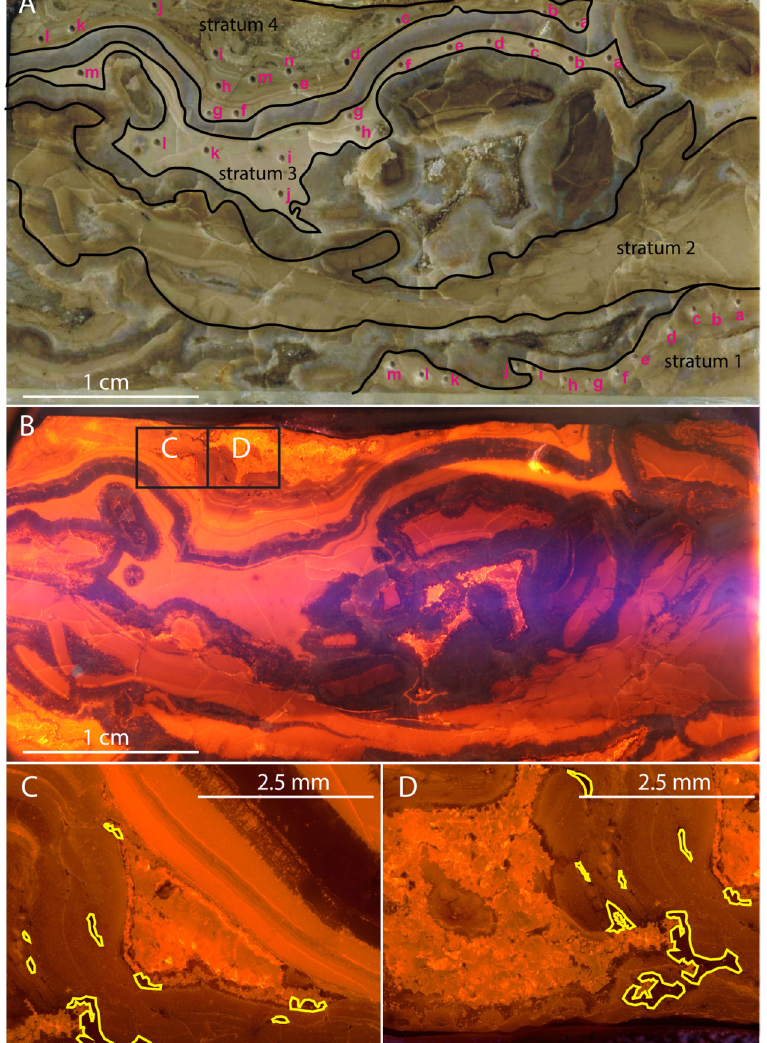
Figure 4. Petrography and cathodoluminescence (CL) results of the studied sample. ( A ) Plain light image of the sample (highlighted in Table 1) and displaying the microsample locations for strata 1 (microsamples a–m), 3, (microsamples a–m) and 4 (microsamples a–n) processed at the University of Kansas for stable isotope analysis. ( B ) CL image of the sample with inset images ( C , D ) indicating the location of high-resolution sampling of microsparite in stratum 4. ( C , D ) High-resolution sampling areas (yellow) of microsparite in stratum 4 for stable isotope analysis.